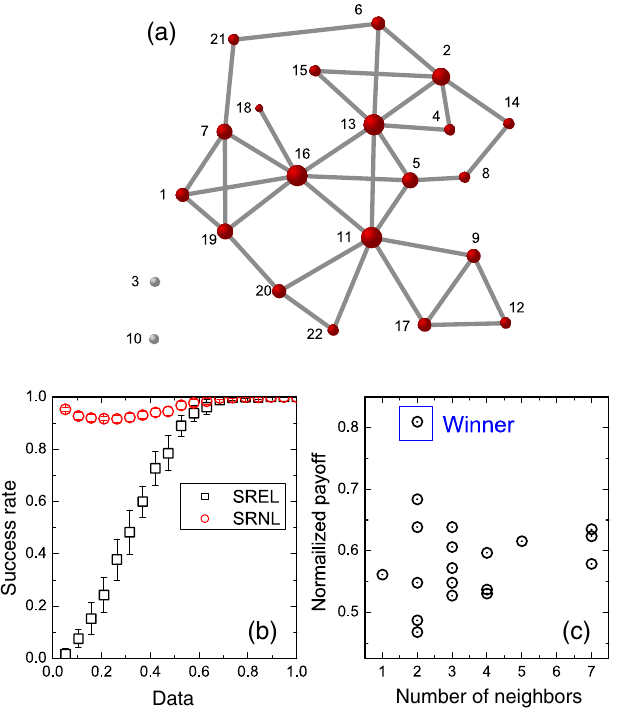
FIG. 4. (a) Structure of the experimental social network. (b) Success rates of uncovering the network topology and (c) normalized payoff of each player as a function of node degrees. The sizes of the red nodes in (a) denote their node degrees, and the two light gray nodes (for players who did not complete the experiment) are isolated without any interactions with other nodes. The 10 independent realizations used in calculating the average success rates were randomly chosen from the database of 31 rounds of